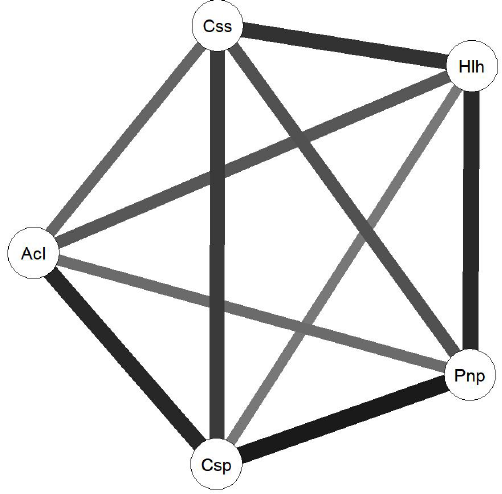
Figure 4. Network diagram created using the R package qgraph. Circles indicate plant-related communities (nodes) and grey lines (edges) link plant-related communities based on the Euclidean dis- tances between them. Weight of each line represents the weight of each edge in terms of the Euclidean distance results between each node. Css is Cistus salviifolius , Hlh is Halimium halimifolium , Pnp is Pinus pinaster , Csp is Cistus psilosepalus and Acl is Acacia lon- giolia